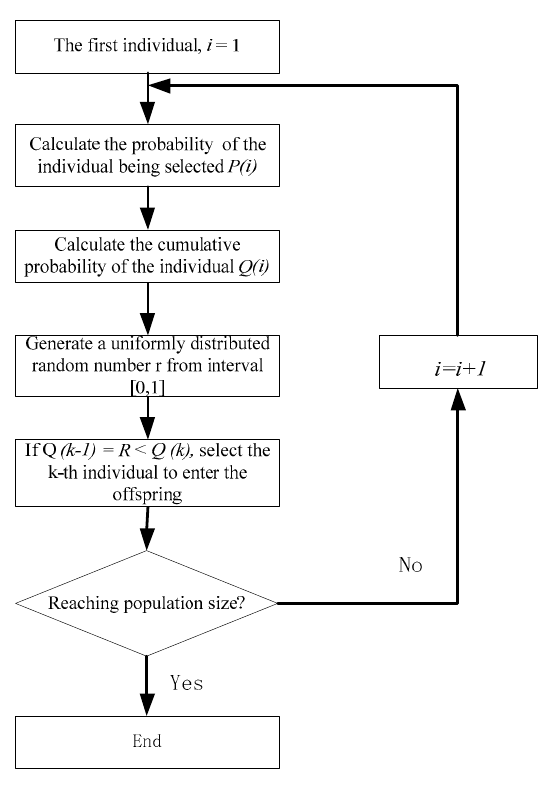
Figure 2. Individual selection step.